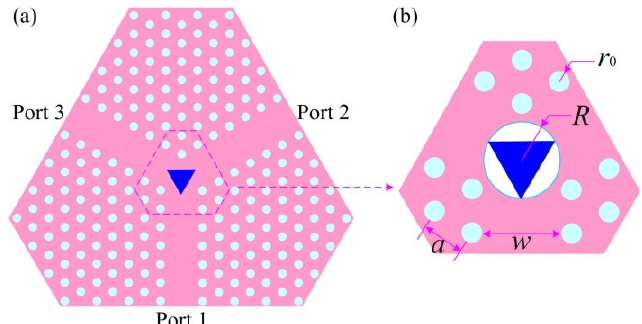
Figure 3. ( a ) The section view of the Y-typed PCW and ferrites; ( b ) the parameter annotations of the PhC and ferrites.